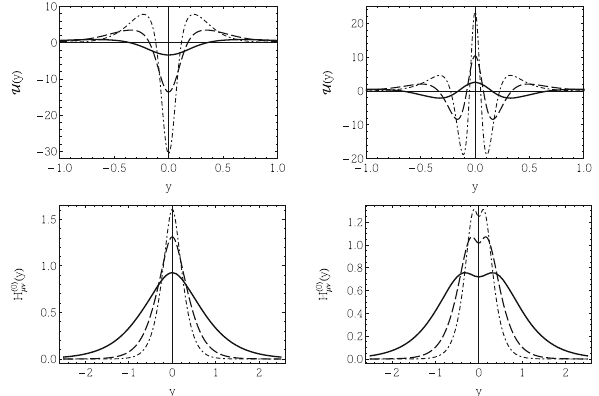
Fig. 21 Potentialofstability(toppanel)andzero-mode(bottompanel) for the model studied in Sect. 3.1, represented for a as in Fig. 1 and ψ = ϕ = 10 (left panel), ψ 0 0